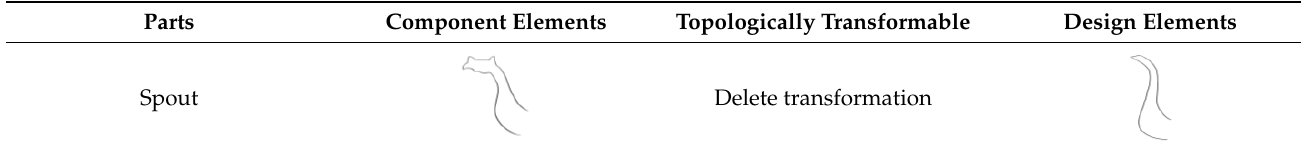
Table 4. Part spout deletion transformation.